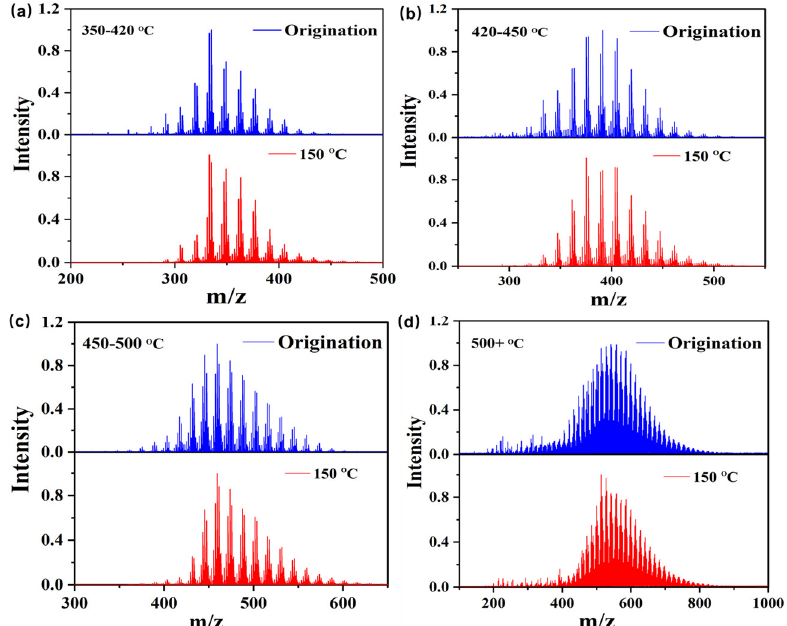
Figure 2. High-resolution spectra of pseudo-components in the range of 25–150 °C: ( a ) 350–420 °C; ( b ) 420–450 °C; ( c ) 450–500 °C; ( d ) 500+ °C.